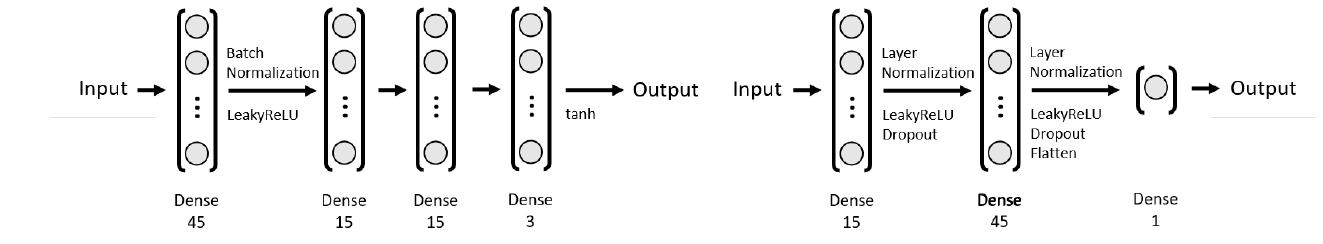
Figure 9. The structure of the generator ( left ) and critic ( right ) for the two-dimensional